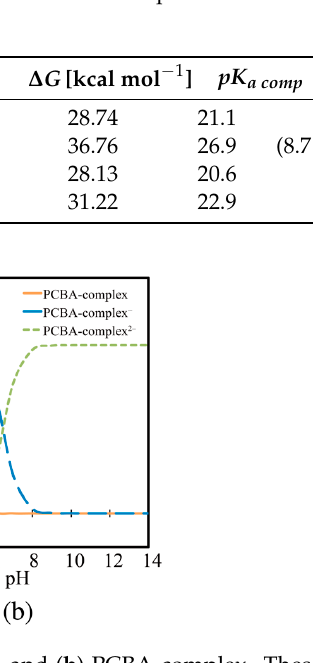
Figure 5. pH ‐ dependent mole fractions for ( a ) PCBA, and ( b ) PCBA ‐ complex. These figures are re ‐ Figure 5. pH-dependent mole fractions for ( a ) PCBA, and ( b ) PCBA-complex. These figures are printed with permission from [42]. reprinted with permission from [42], Copyright 2016,